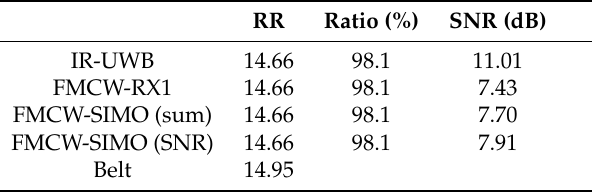
Table 6. RR Results of measurement with harmonics.